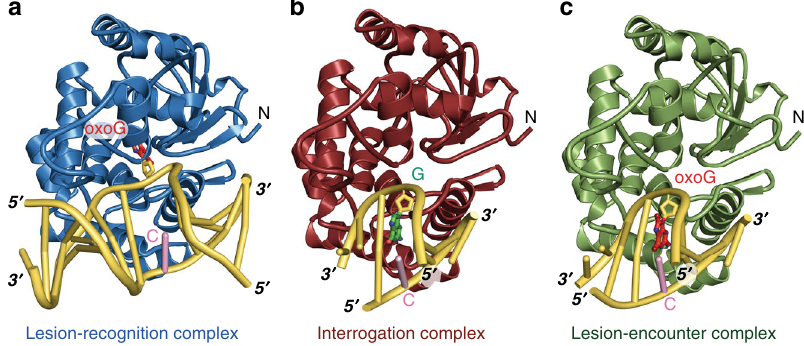
Fig. 2 Interaction of human 8-oxoguanine DNA glycosylase I (hOGG1) with DNA. a Overall structure of a crosslinked lesion-recognition complex, xLRC, with an extrahelical oxoG bound in the enzyme active site. b Structure of the sequence-matched interrogation complex, IC, with a fully intrahelical target G • C base-pair. c Structure of the sequence-matched encounter complex, EC, with a fully intrahelical target oxoG •